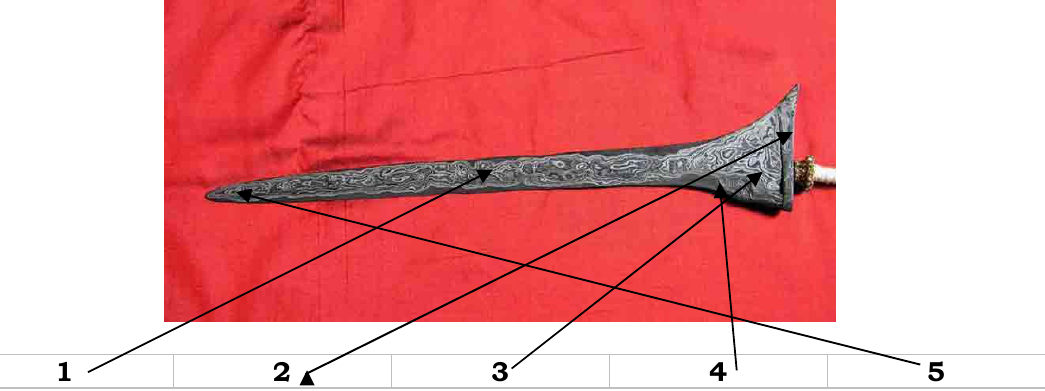
Figure1. Typical Straight